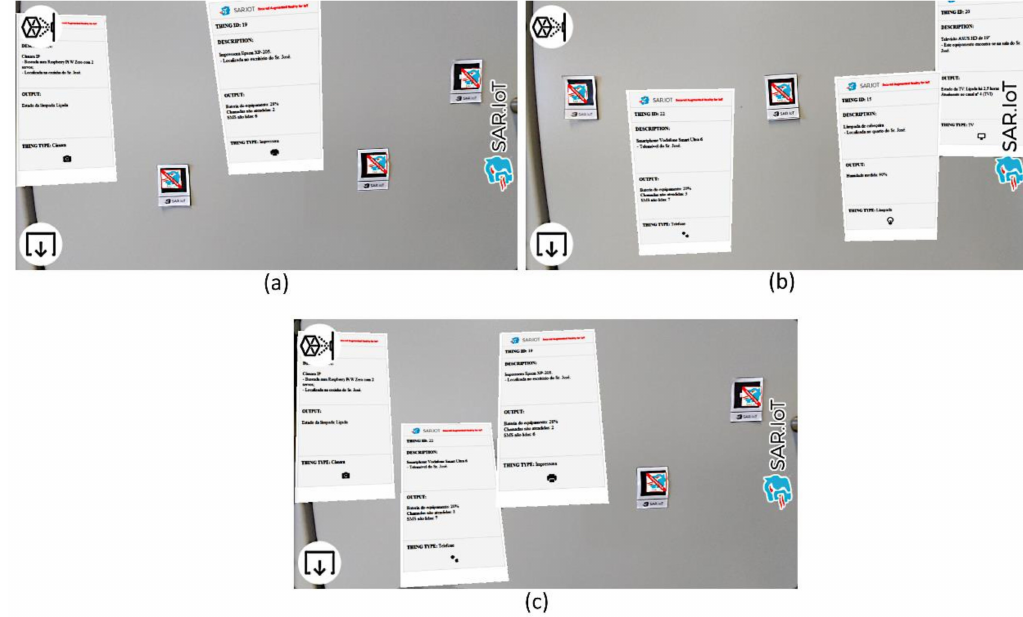
Figure 27. Available and not available AR markers for users U1 ( a ), U2 ( b ) and U3 ( c